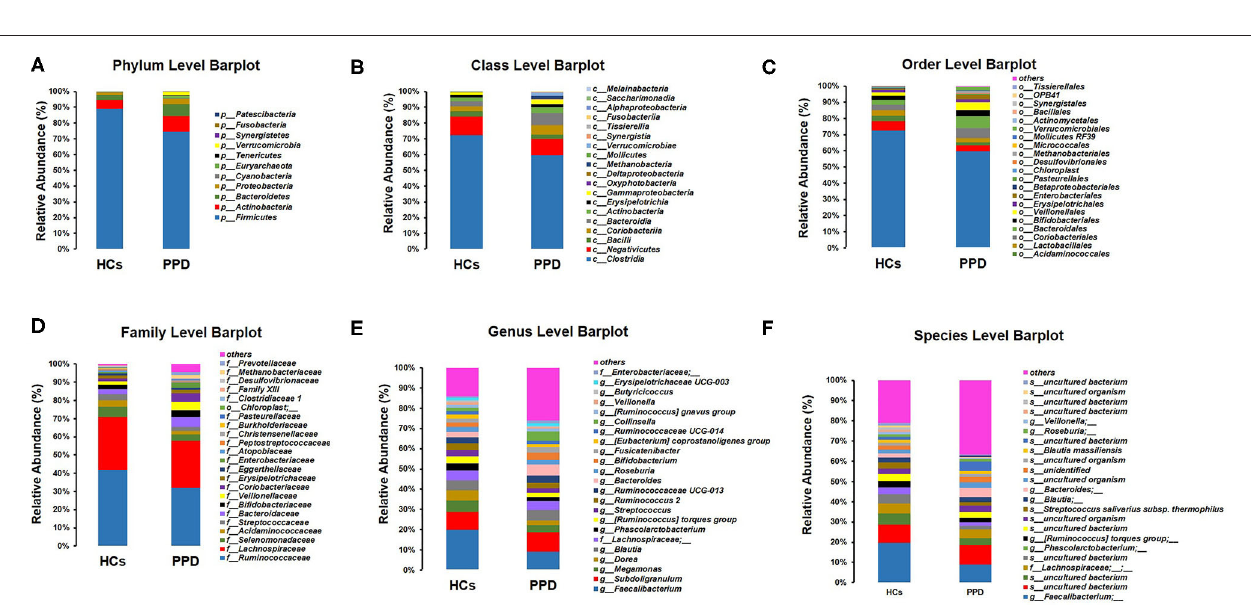
FIGURE 4 | Composition of microbial communities. Phylum level (A) ; Class level (B) ; Order level (C) ; Family level (D) ; Genus level (E) ; Species level (F) .